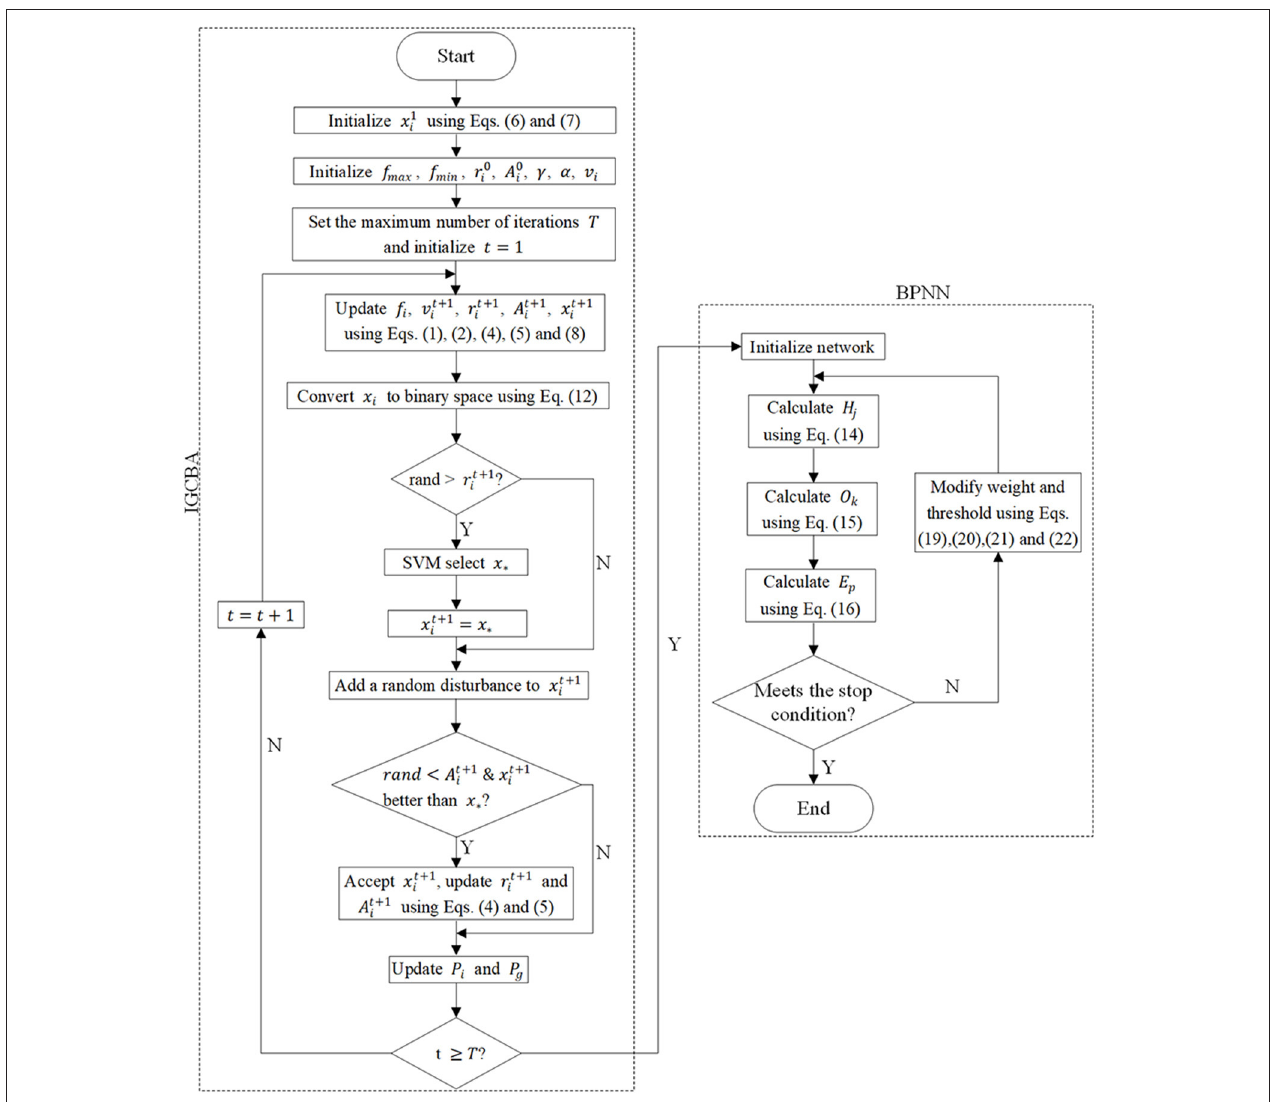
FIGURE 1 | The flowchart of